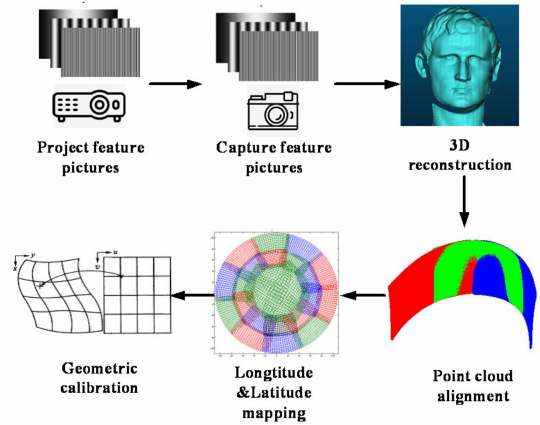
Figure 1. Algorithm flow chart.